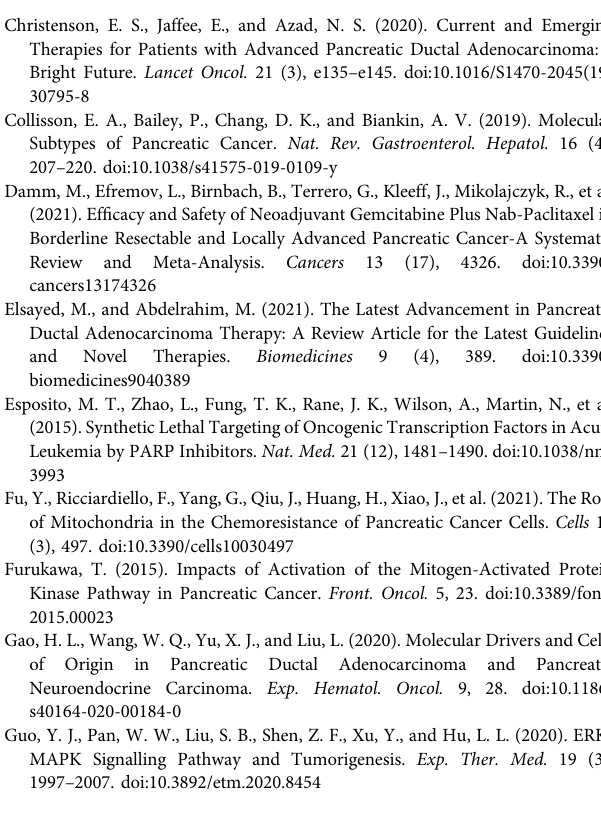
Supplementary Figure 1 | Quanti fi cation analysis of the cell cycle related proteins. (A) Cyclin E1/Vinculin Ratio. (B) Cyclin A1/Vinculin Ratio. (C) p27 KIP1 /Vinculin Ratio. ImageJ-mediated quanti fi cation analysis has been performed processing three distinct Western blotting experiments for every cell cycle related protein, and housekeeping protein (Vinculin). Median value ± SD of the relative Ratio is reported in chart. Representative Western blotting fi lms are displayed in Figure 4D . Supplementary Figure 2 | Effects of PD98059 inhibitor on p44/42 MAPK phosphorylation in PDAC cells. MIA PaCa-2 (A) and PANC-1 (C) were treated and not (control) with 10 μ M PD98059 for 2 h with the purpose of assessing both phospho- p44/42andp44/42levelsbyWesternBlotting. (B) Growthimpactof10 μ MPD98059for 24 h in PANC-1 cells, expressed in percentage of control as mean ± SD of three independent experiments. * p < 0.05 by unpaired Student ’ s